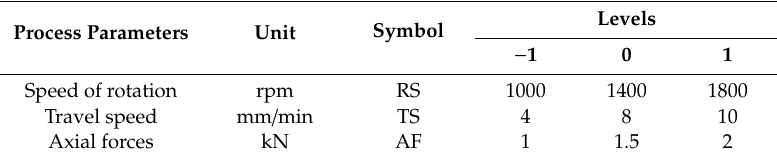
Table 5. Process parameters and levels.